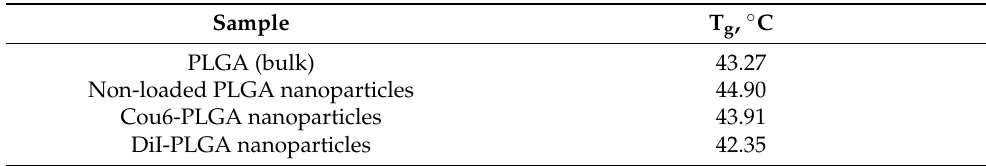
Table 4. Glass transition temperature (T g ) of PLGA (bulk) and PLGA nanoparticles, both non-loaded and loaded with DiI or coumarin